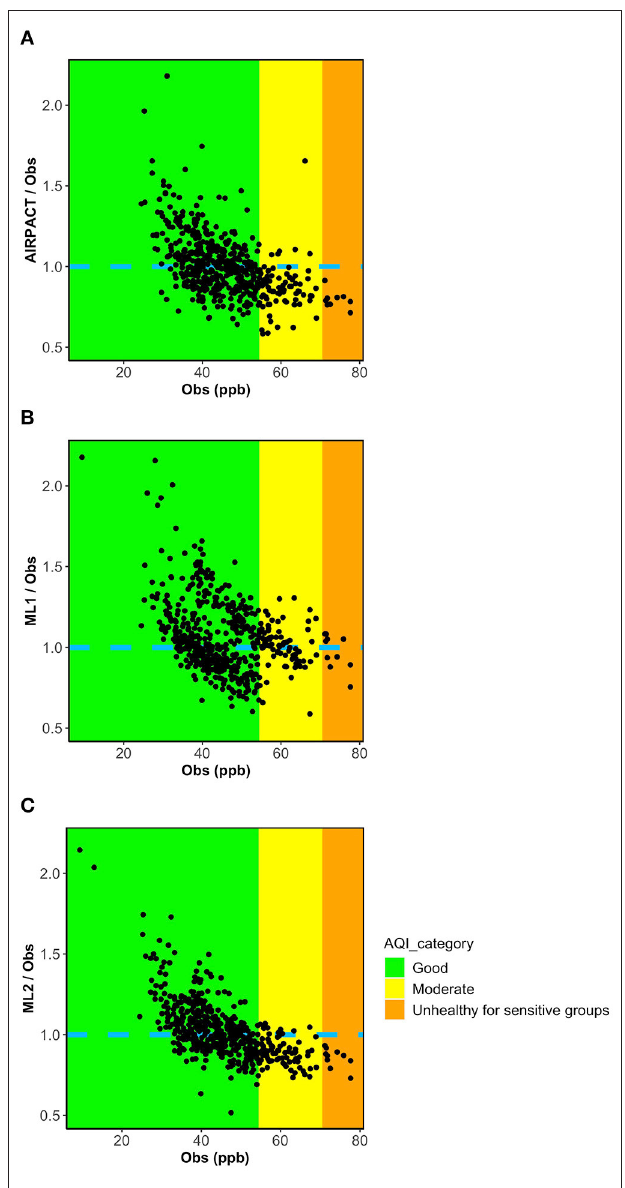
FIGURE 5 | Ratio plots of model prediction to observations vs. observations for three models (A) AIRPACT, (B) ML1, and (C) ML2.